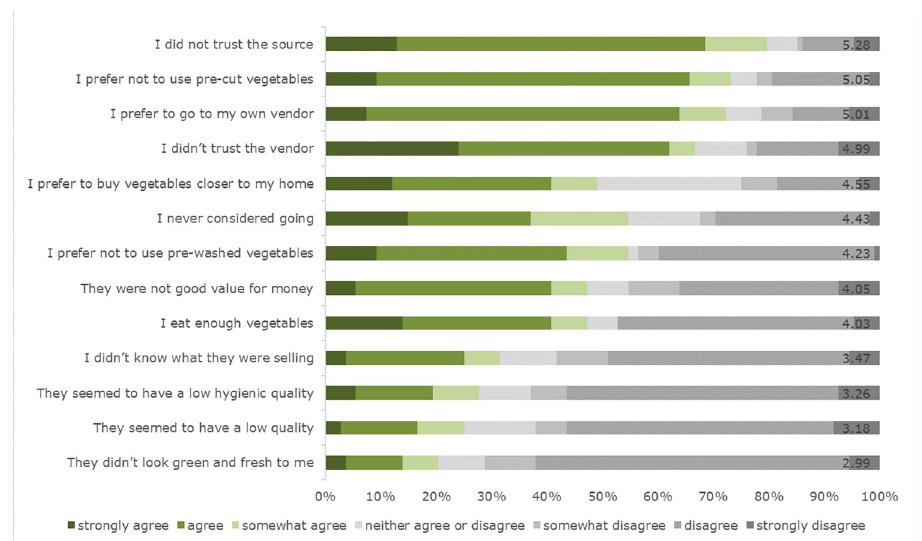
Fig 3. Reasons for not buying GLV from the intervention at the market (N = 108) in percentages and mean values added at the end of the